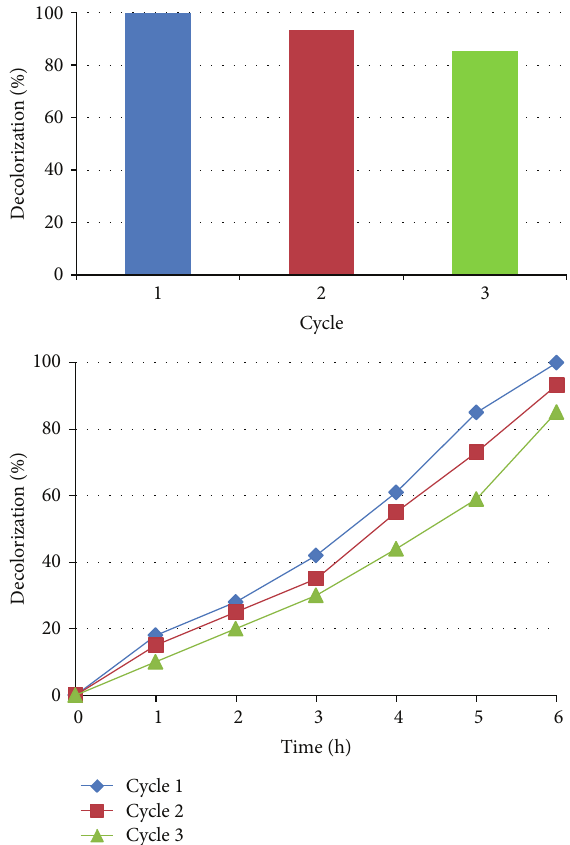
Figure 10: The reusability of Ag-TiO 2 /Fe 3 O 4 as demonstrated in decolorization of indigo carmine under visible light